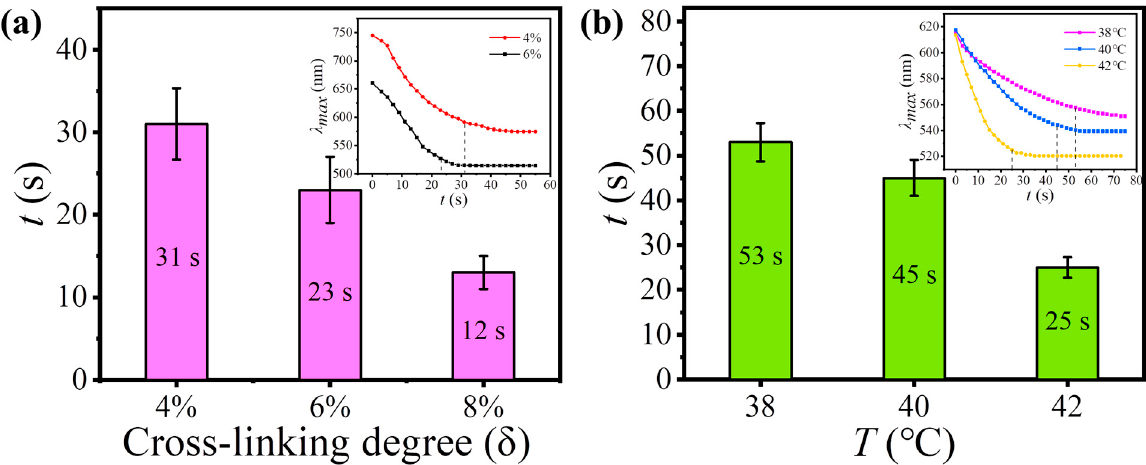
Figure 5. ( a ) The response time of TRPCF-PNC as a function of the cross-linking degree of the embedded PNCs. The inset shows the shift in the reflection wavelength at different points in time when TRPCF-PNC was transferred to 44 ◦ C from 26 ◦ C. ( b ) The response time graph under different stimulus temperatures of TRPCF-PNC with 10 wt% NHMA in the P(NIPAM-co-NHMA) matrix. The insert shows the corresponding change curves of the reflection wavelength with time during the stimulus process.